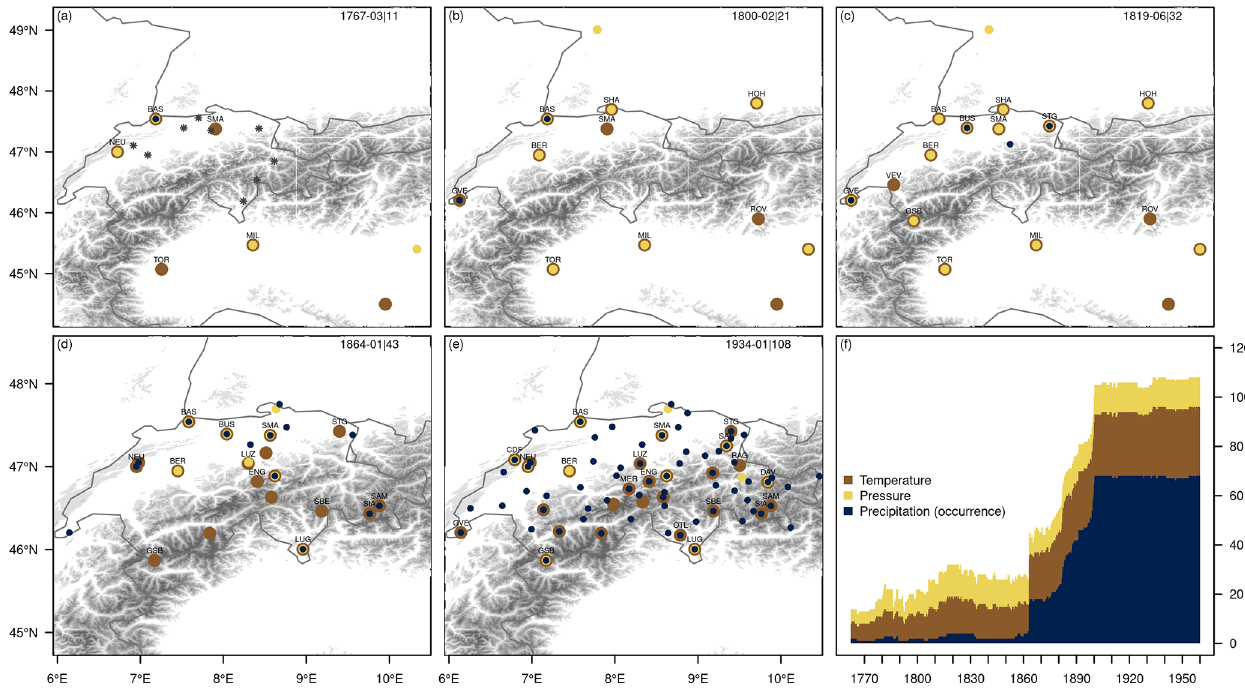
Figure 1. (a–e) Station measurements as they are available for five different months from 1763 to 1960. The upper right-hand numbers denote the example month and the total number of measurements for this time step. Labelled stations are used in the ensemble Kalman fitting. Panels (d) and (e) show the networks as used in Pfister et al. (2020). Asterisks in (a) denote locations of independent measurements, which are used for an evaluation of the reconstruction. (f) Evolution of temperature, pressure, and precipitation measurements throughout the entire period. Precipitation includes precipitation occurrence and precipitation